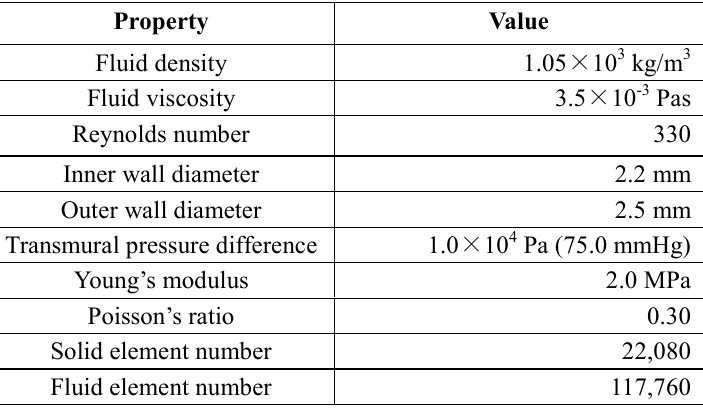
Table 1 A List of parameters of the computational